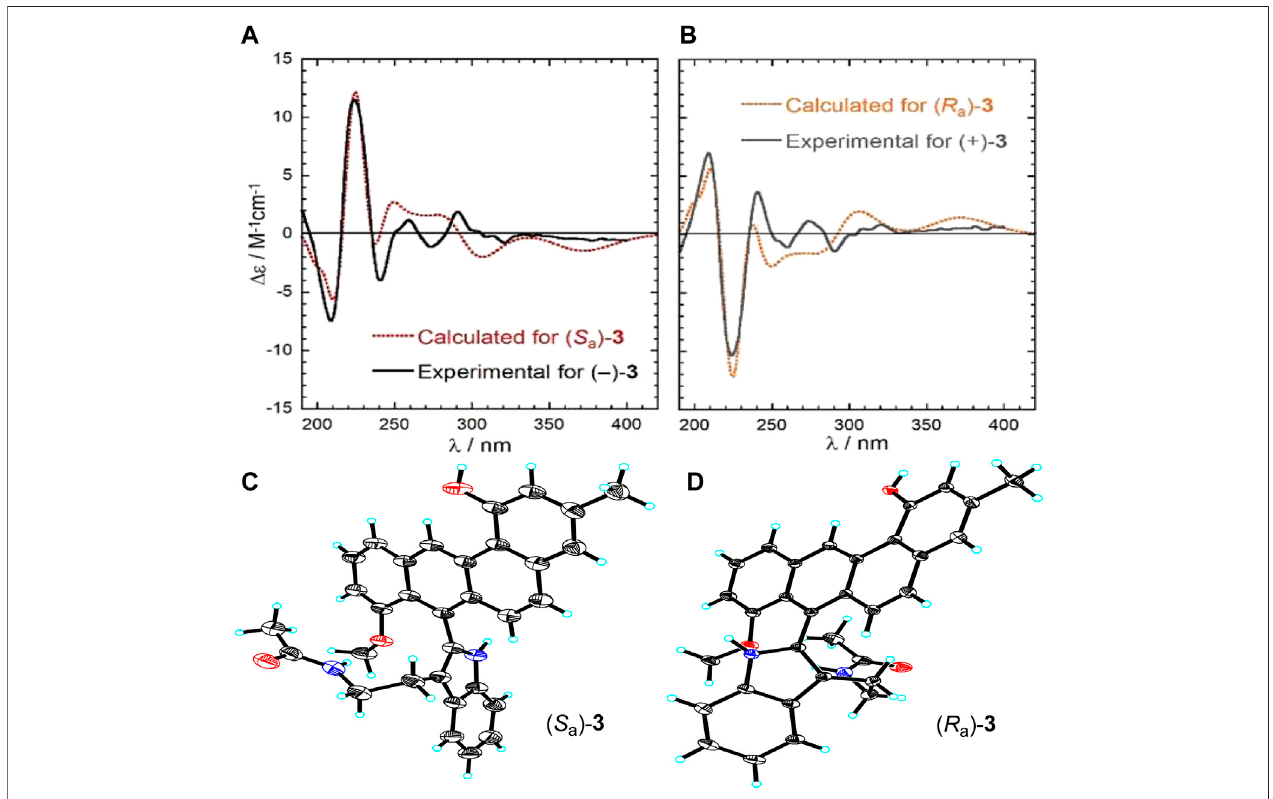
FIGURE 4 | (A) Experimental and calculated ECD spectra of( − )-( S a )-3, (B) experimental and calculated ECD spectra of(+)-( R a )-3, (C) X-ray crystal structure of( S a )-3, (D) X-ray crystal structure of ( R a )-3.